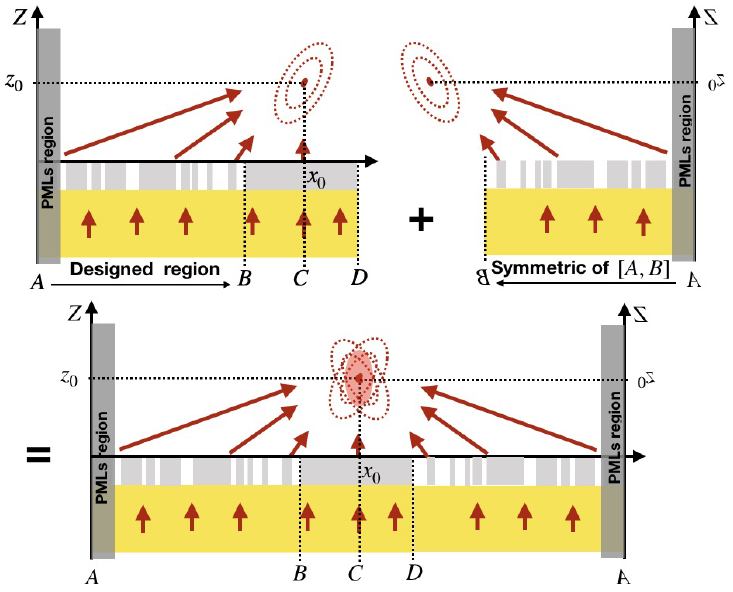
Figure 7. Design of a one dimensional flat metalens: illustration of the two-metacells-stitched